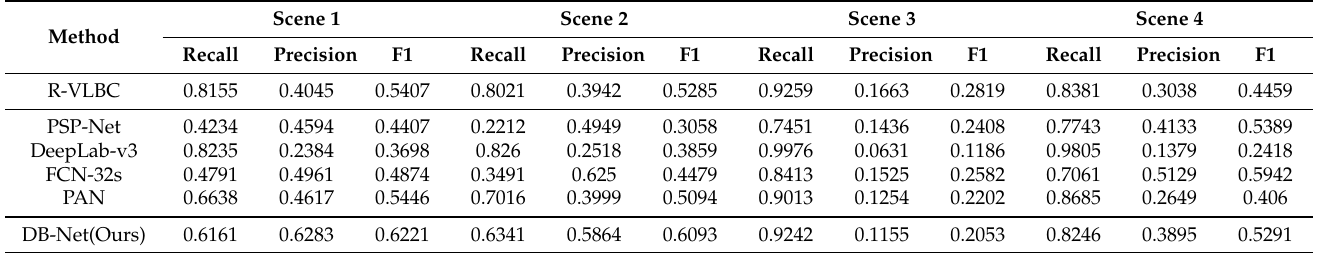
Figure 8. Average Recall, F1, and Precision in four senses. Table 4. Comparison between our method and state-of-the-art methods with varied metrics in LoSSoV-video test